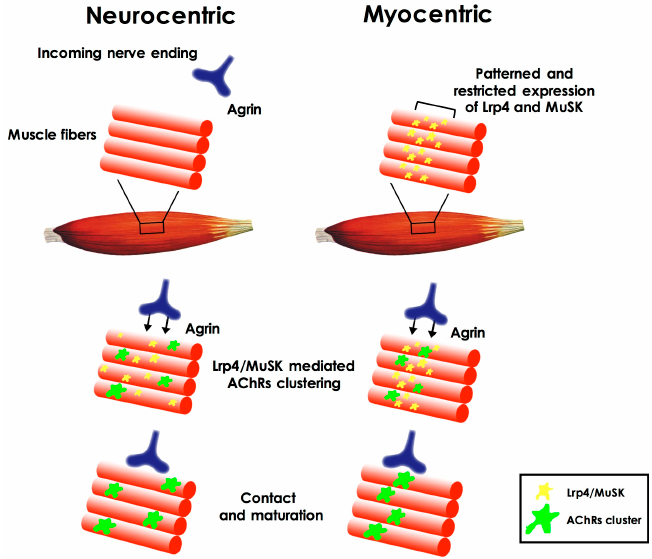
Figure 1. Neurocentric and myocentric hypotheses of neuromuscular synaptogenesis. According to the neurocentric hypothesis, the clustering of the acethylcholine receptors (AChRs) on the muscle fiber plasma membrane is primarily triggered by the release of neural agrin and through activation of the muscle specific kinase (MuSK) and low-density lipoprotein receptor-related protein (Lrp4). According to the myocentric hypothesis, patterned and restricted expression of MuSK and Lrp4 on the fiber plasma membrane defines the area in which neuromuscular synapse will form, before the arrival of the incoming nerve ending (see text).